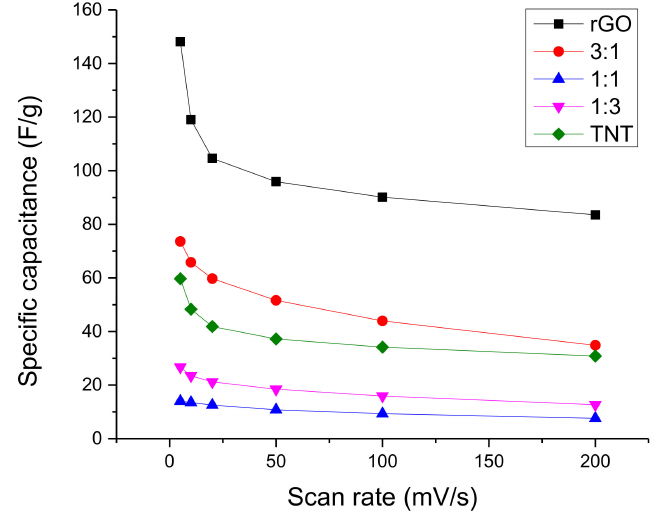
Figure 6. Specific capacitance variation with scan rate of GO/TNT